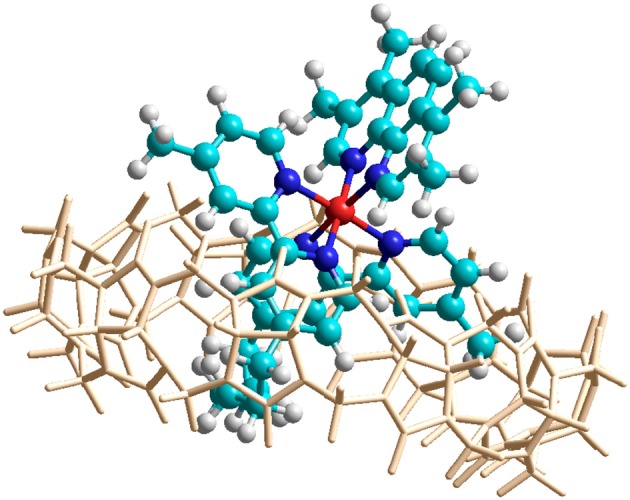
Molecular modeling of the encapsulation of α-Me4phen-7 with Q[10] using HyperChem software. The color of the atoms of α-Me4phen-7 are: H, white; C, cyan; N, blue; and Ru, red.